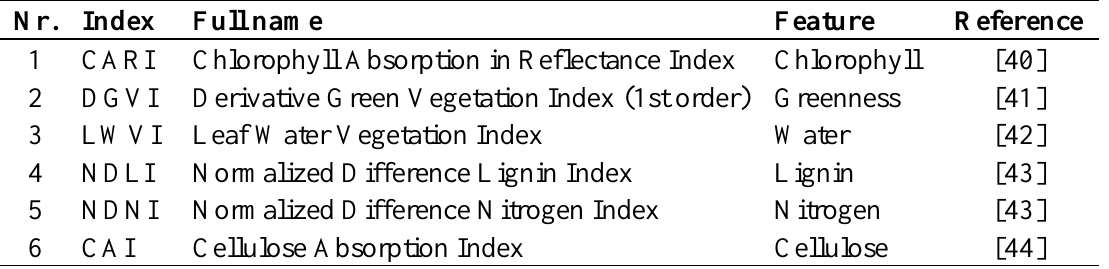
Table 1. Overview of the selected vegetation indices and their canopy related feature. For index formulas see Dorigo et al .